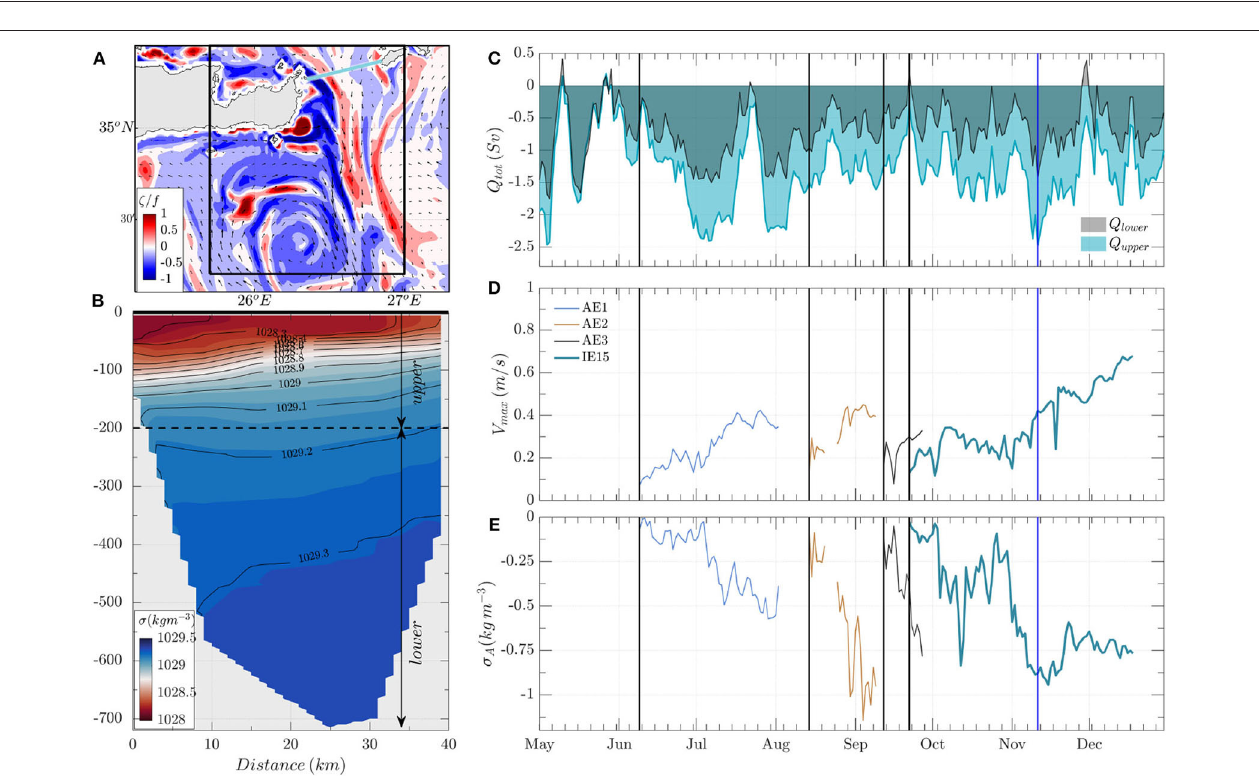
FIGURE 12 | (A) Surface vorticity fields ζ/ f and (B) vertical section of the density σ ( kg / m − 3 ) in the Kasos Strait for the 11 November 2015. Temporal evolution of the Kasos Strait outflow Q separated in surface (0 − 200 m ) and subsurface outflow (200 − 700 m ) in (C) . The dates shown with the vertical black lines indicate the first detection of long-lived anticyclones during the same period. The temporal evolution of the eddy characteristic velocity V max and the density anomaly σ A is shown for the different anticyclones AE1, AE2, AE3, and M_IE15 in (D,E) .